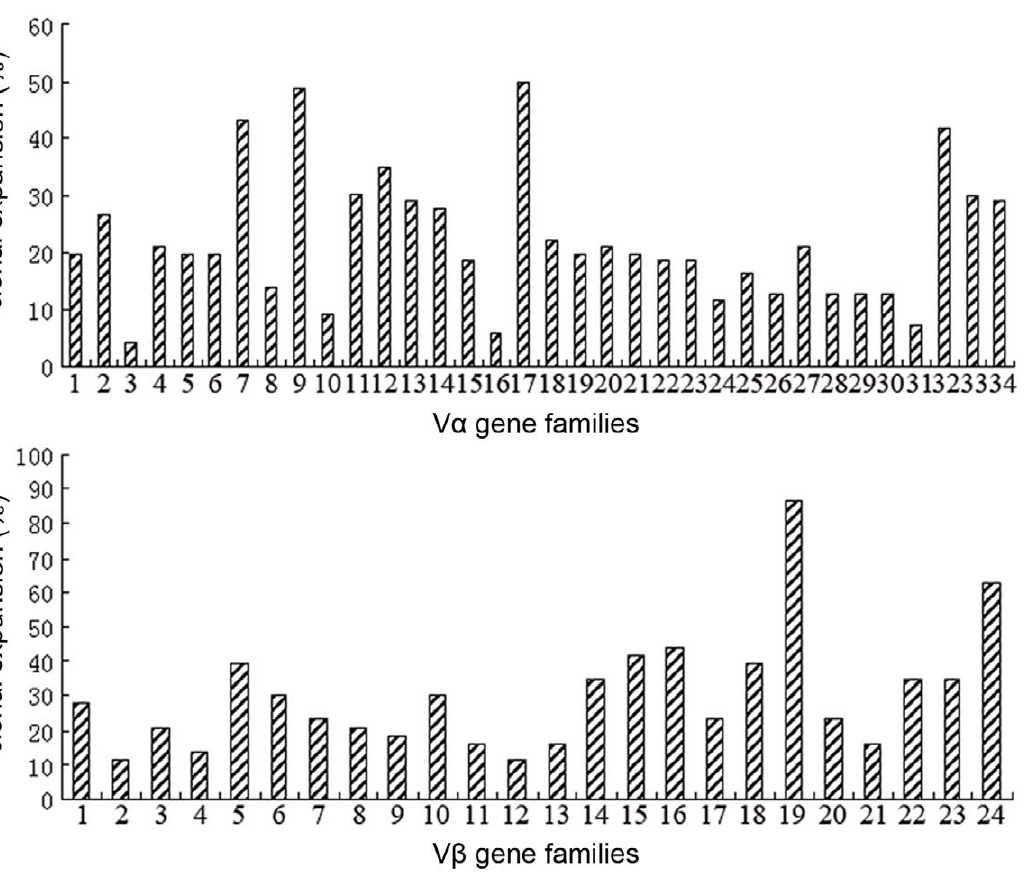
Figure 4. The preferred usage of TCR V a and V b gene families. The percentage was calculated as the preferred usage frequency of corresponding gene family.